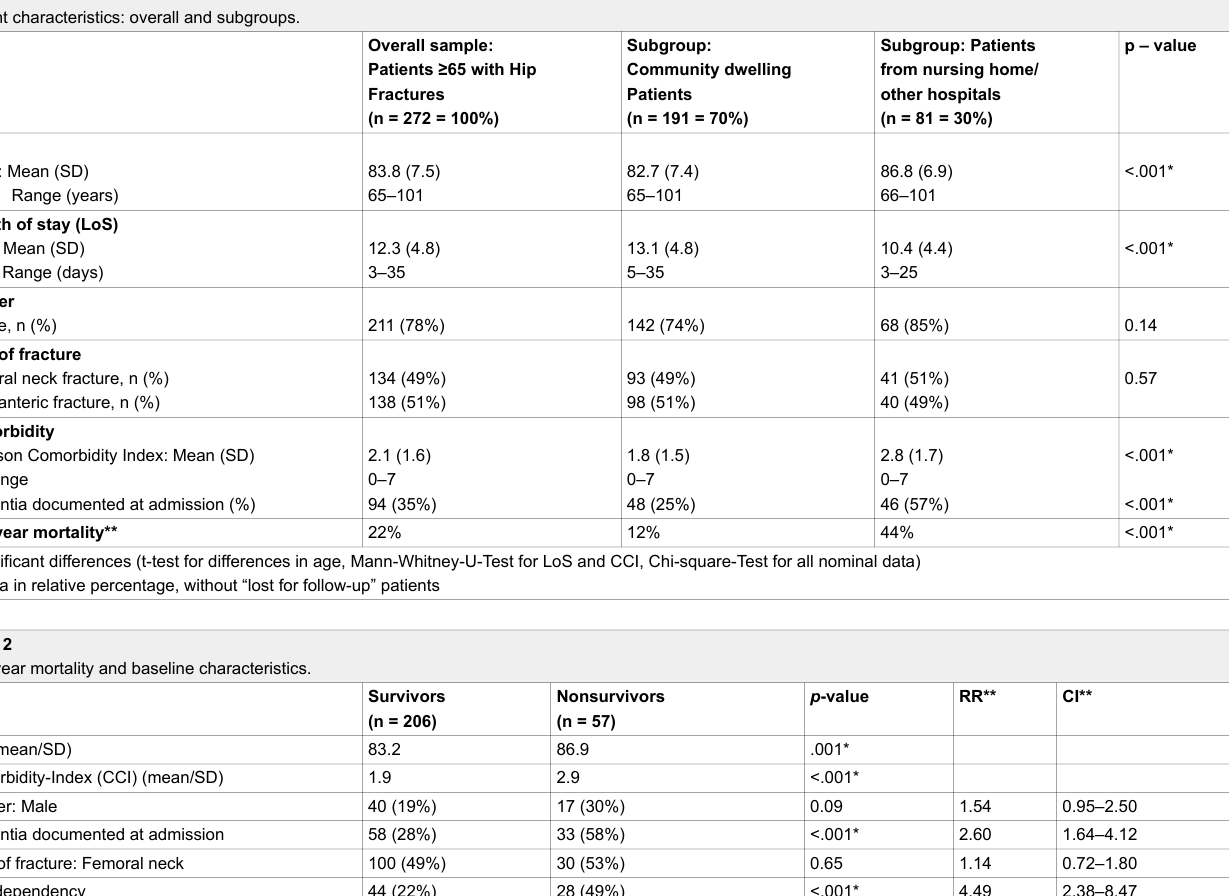
Table 1 Patient characteristics: overall and subgroups.